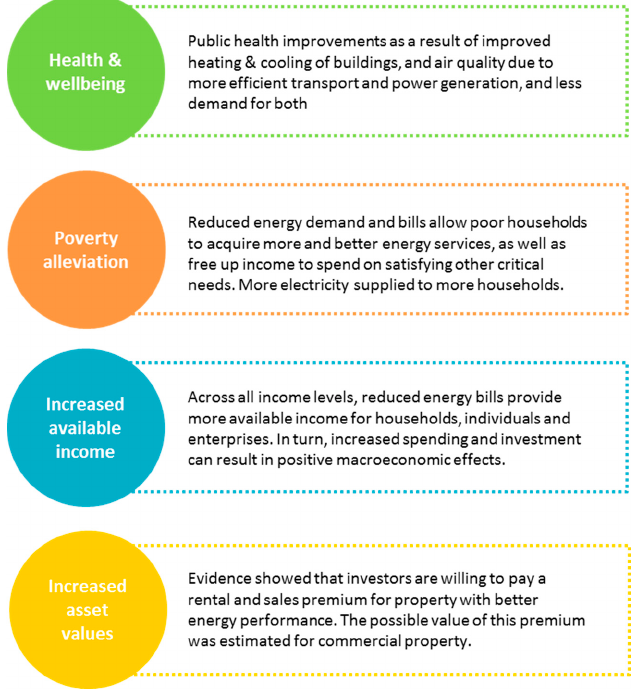
Figure 6. Social impacts derived from the scenarios proposed [27].